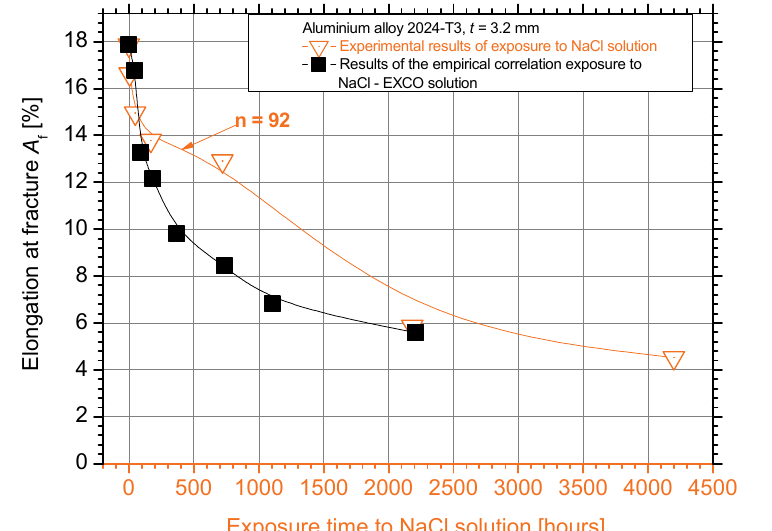
Figure 9: Correlation of the elongation at fracture A f decrease due to exposure to the EXCO solution as well as to 3.5 wt. % NaCl